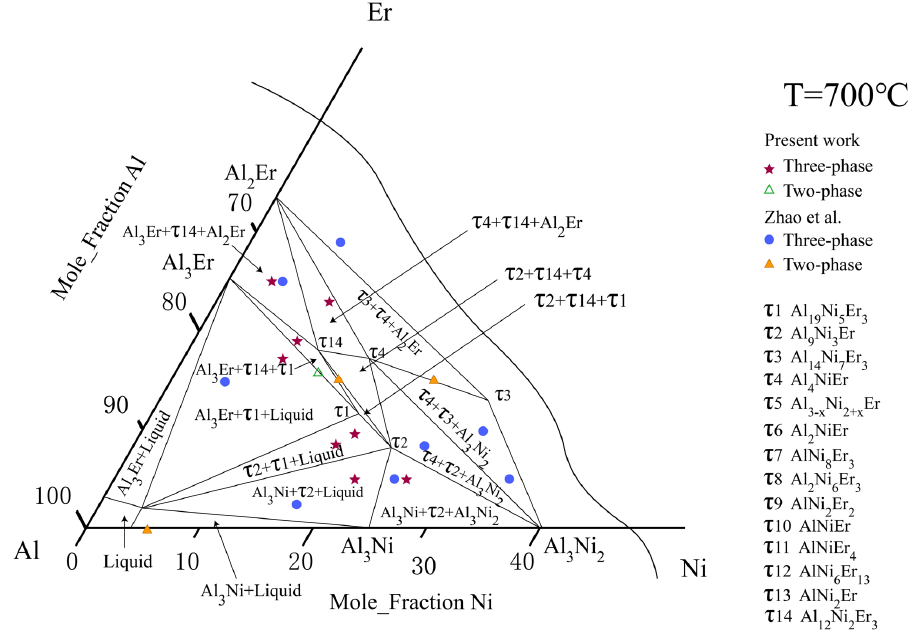
Figure 17. Calculated isothermal sections of the Al–Ni–Er ternary system at 700 °C compared with experimental data from this work and Zhao et al. [34] .